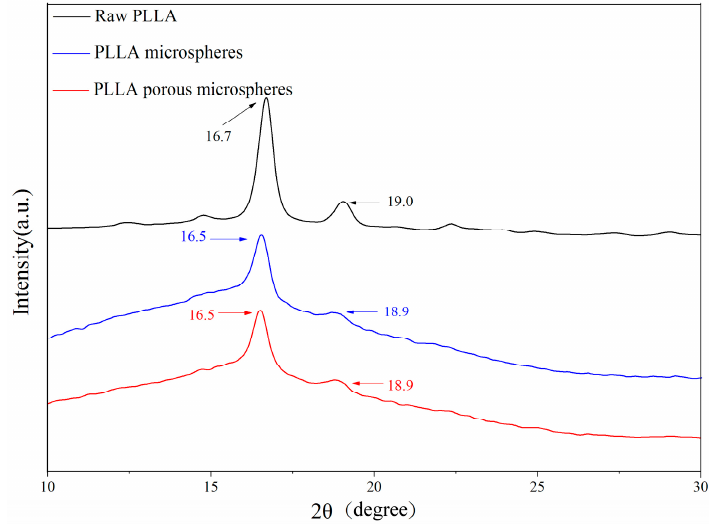
Figure 5. XRPD spectra of PLLA PMs.